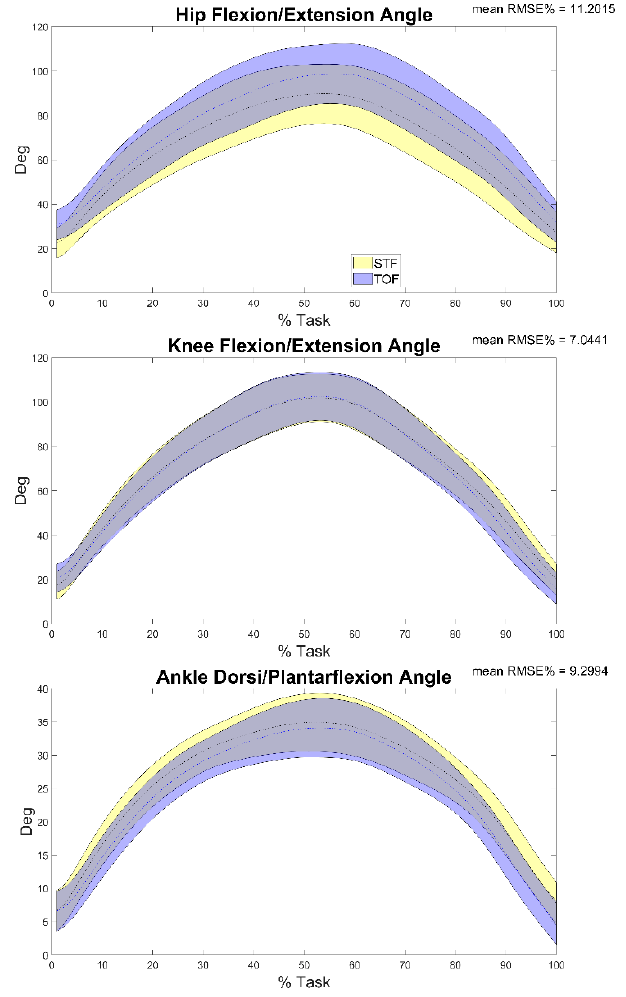
Figure 3. Hip, knee and ankle flexion/extension angles during the task calculated through stereophotogrammetry (STF—blue) and video ‐ based tracker (TOF—yellow) and the mean RMSE% of the comparison between the two. Averages plus and minus one standard deviation are reported as colored bands.